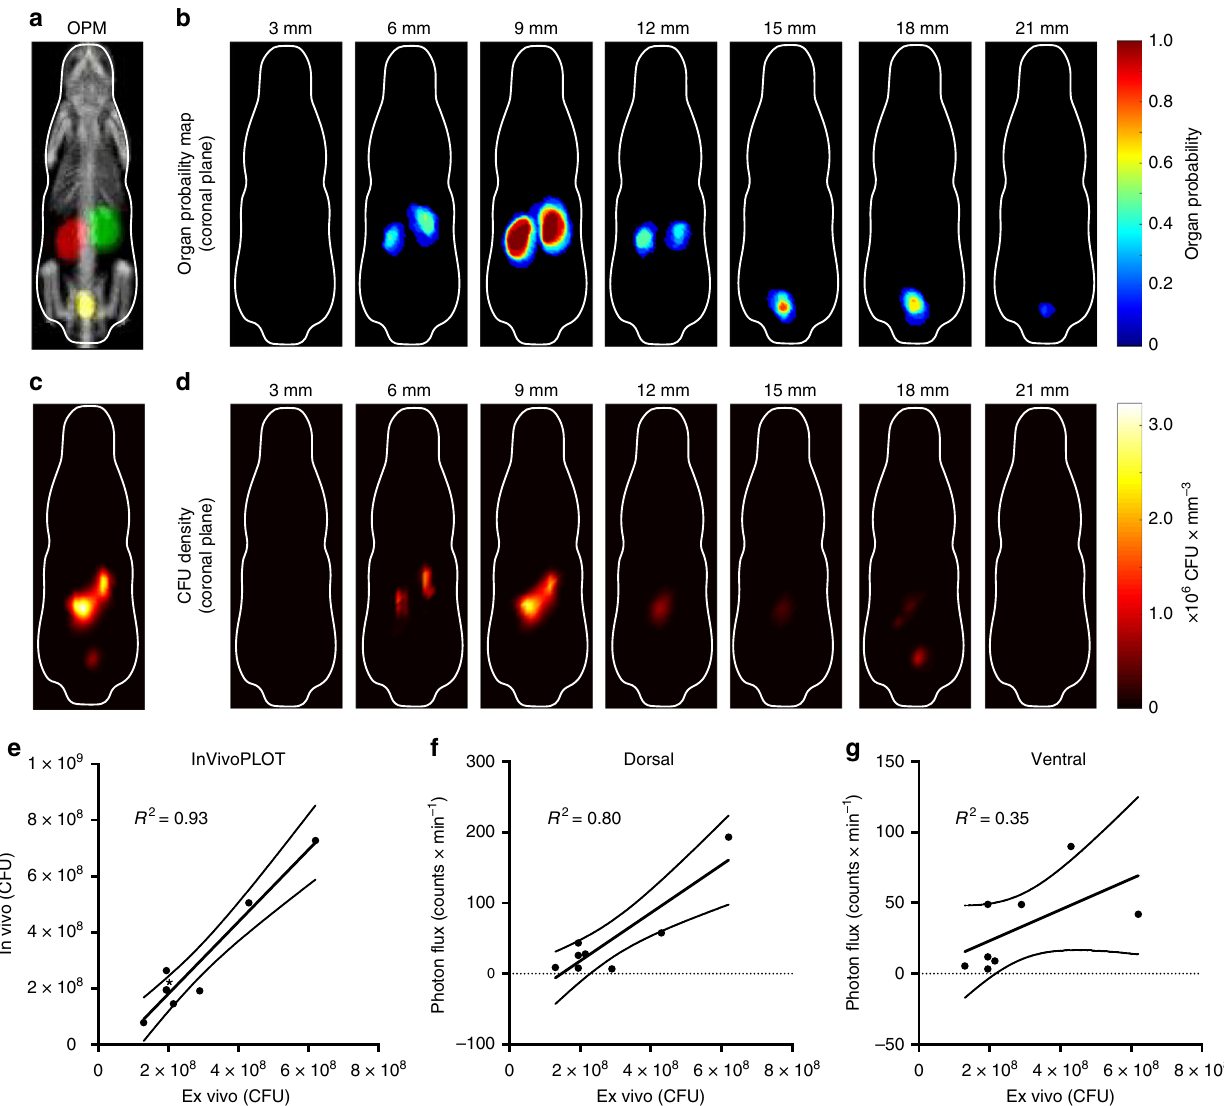
Fig. 6 BLt reconstruction of bacterial infection with OPM coregistration. Spatial distribution of lux-bacteria was reconstructed in a UTI model of female C3H/HeJ mice ( n = 8, 24 g). a Maximum intensity projection of kidney, bladder, and skeleton OPM and schematic outline of BCAM as reference. b Coronal slices of kidney and bladder OPM in 3 mm increments from the dorsal to ventral side. c Maximum intensity projection and d aligned coronal sections from reconstructed bacterial density distribution of mouse with pyelonephritis. e Calculated total in vivo CFU count of kidney using BLt vs total ex vivo CFU count of harvested kidneys. The Pearson correlation coef fi cient is R 2 = 0.93. f , g Measured total light intensities of kidney ROI on animal surface using BLi vs total ex vivo CFU count of harvested kidneys quanti fi ed by serial plating. f Plot corresponding to dorsal view of bioluminescence image ( R 2 = 0.80) and g to ventral view of bioluminescence image ( R 2 = 0.35). * Two data points (2 × 10 8 ) are overlapping in